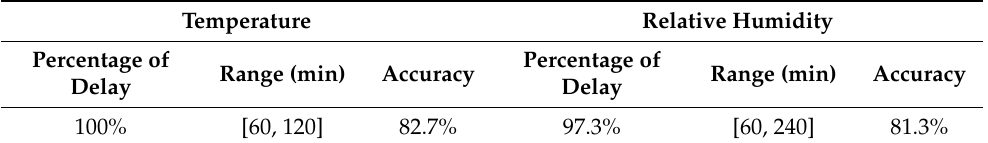
Figure 7. Histogram of peak delays of ( a ) temperature; ( b ) relative humidity. Table 1. Hygrothermal transfer with its peak delays.